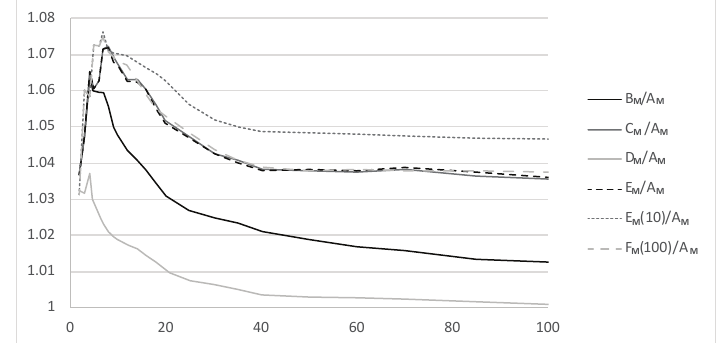
Figure 7. This diagram depicts quotients with A M on the second subset of the third dataset (corresponding to k = 4). Algorithm E M (10) outperforms the others. However, the ratios seem to stabilise at a constant